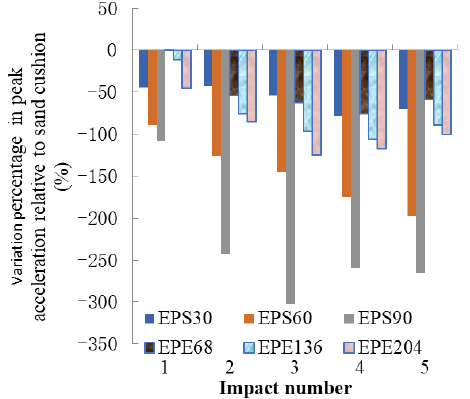
Figure 12. Peak acceleration curves of the sand – EPS and sand – EPE composite cushions with differ-